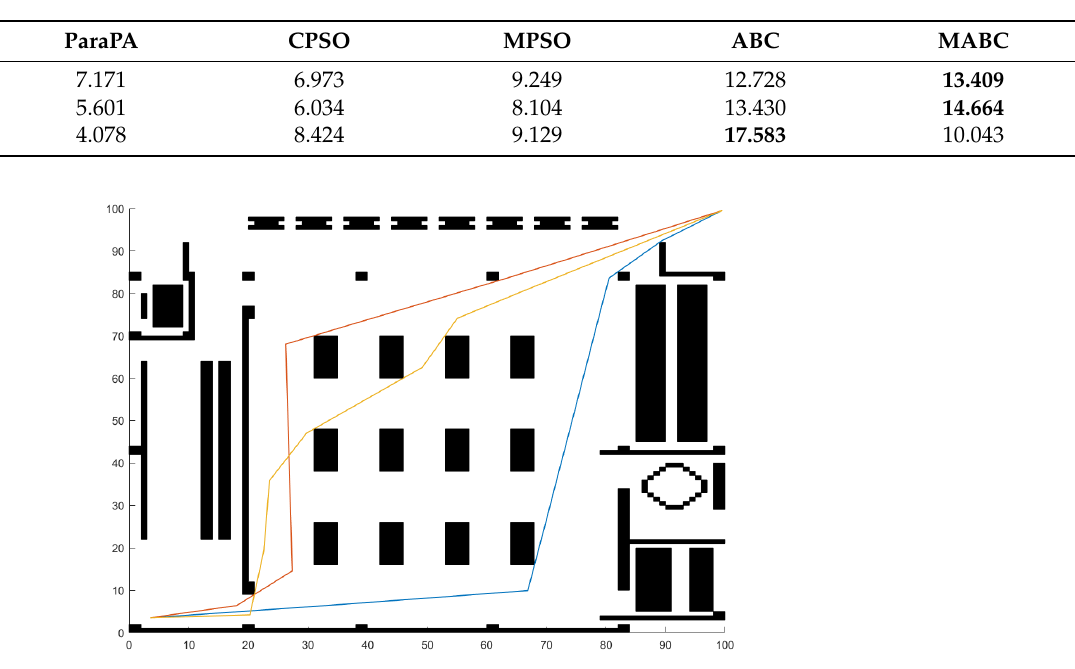
Table 6. Diversity of individuals (DI) on 100 × 100 maps.